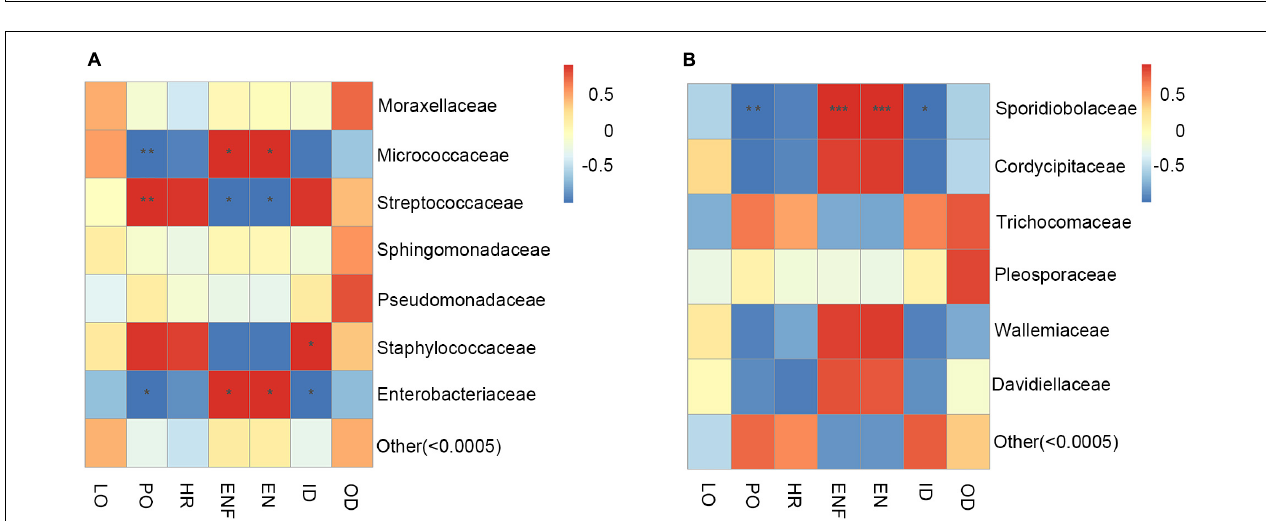
FIGURE 6 | (A–J) The relative abundance of intestinal microbiota metabolism from adult H. axyridis fed with different diets. The different small letter above bars indicate significant difference by Tukey’s test ( P < 0.05).